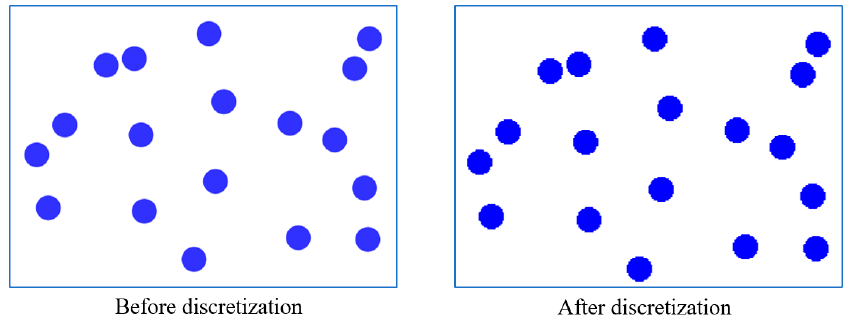
Figure 3. Particles before and after discretization in the geometric model.